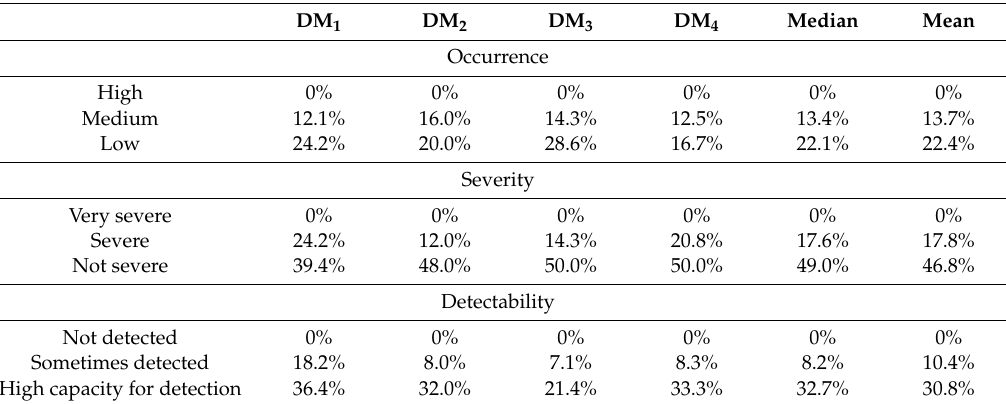
Table 8. Preferential values given by decision makers.